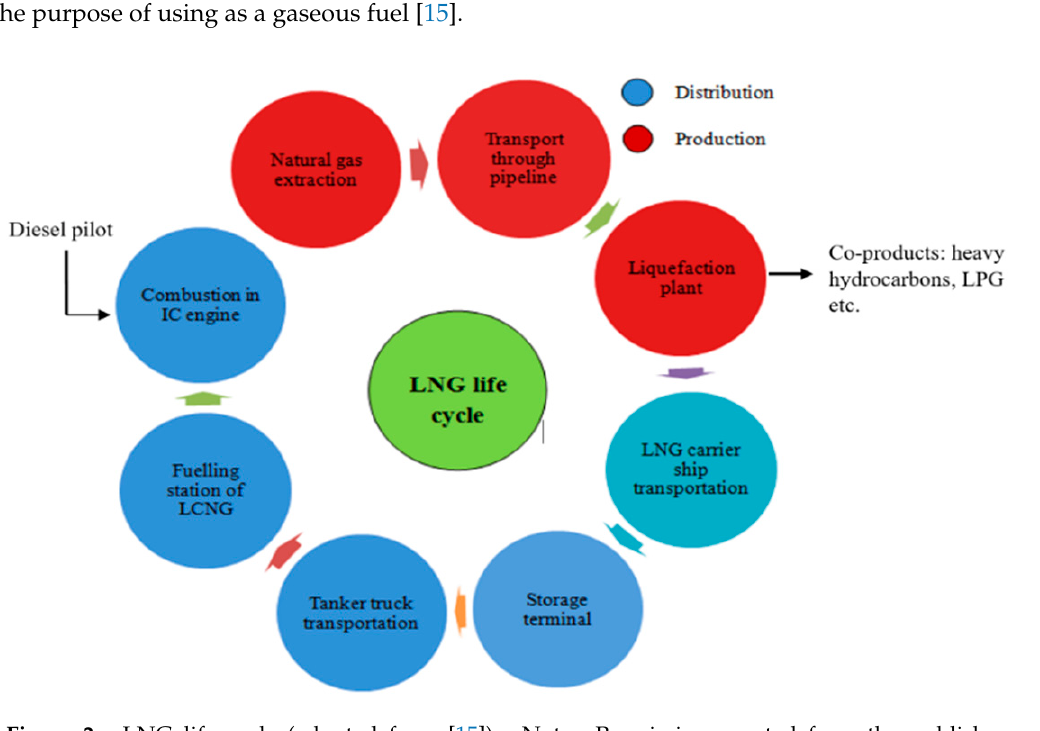
Table 1. Average LNG as well as diesel fuel cost worldwide (unit conversion) [14].